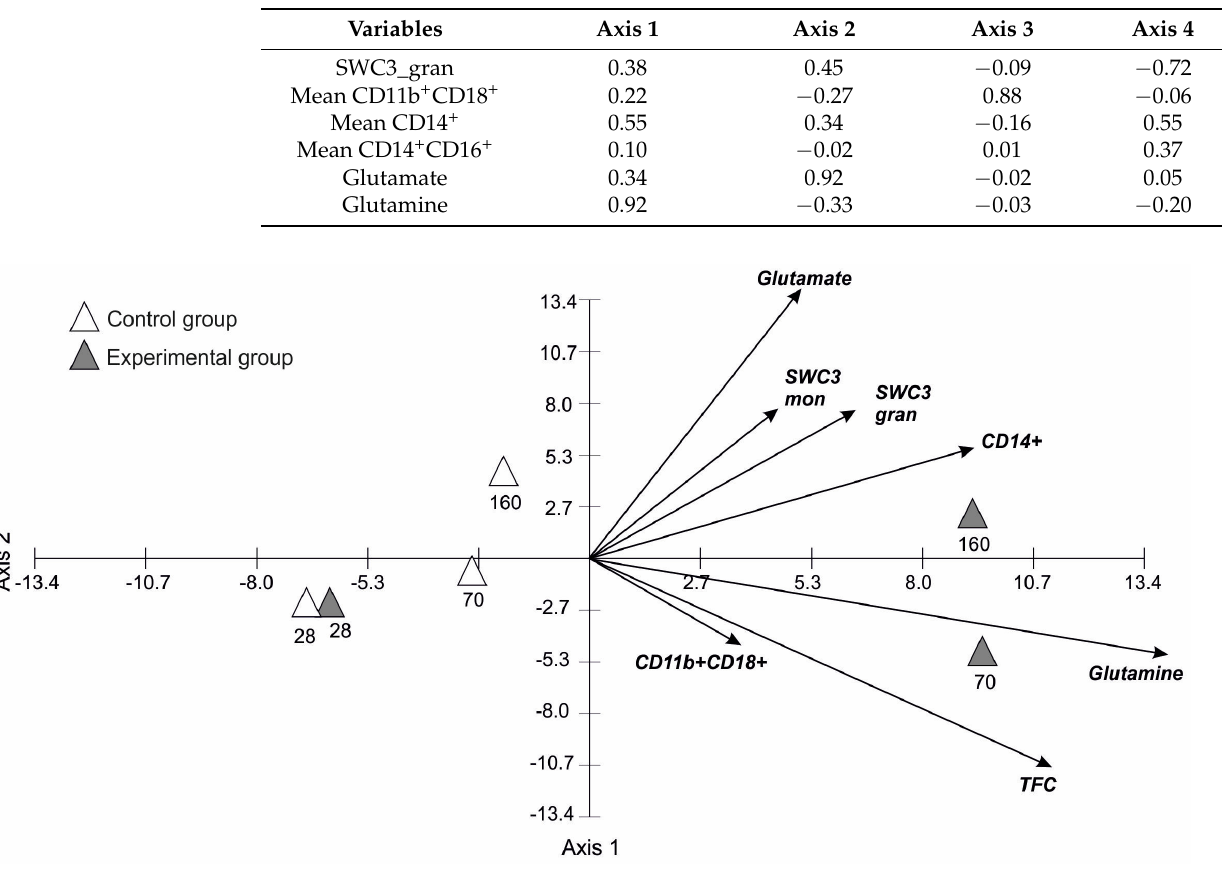
Figure 5. Results of PCA based on the mean level of blood factors in time. Table 6. Results of PCA based on the average level of blood factors of the control and experimental groups di ff ering in the presence of glutamine in the diet. Values in bold are statistically signi fi cant for p <